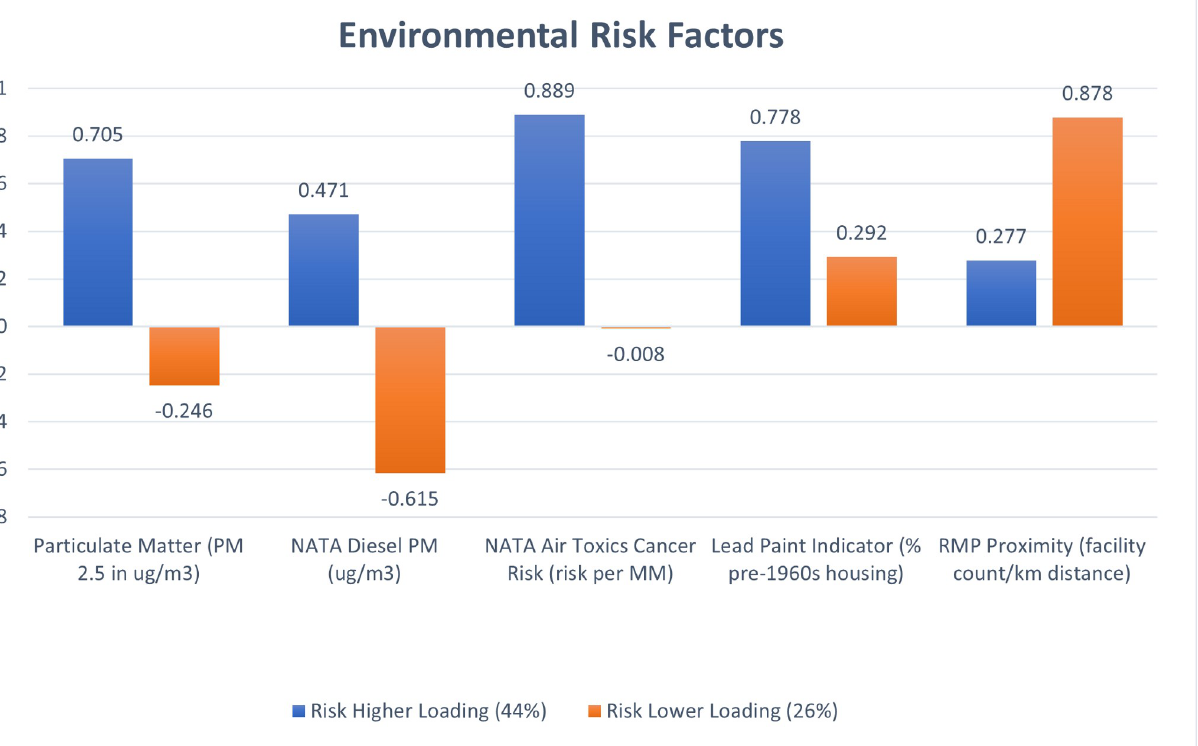
Fig 3. Population vulnerability factors identify the two components from PCA and statistically represent the parallel populations within each small town. Higher scores indicate more vulnerability. https://doi.org/10.1371/journal.pone.0252127.g003 PLOS ONE | https://doi.org/10.1371/journal.pone.0252127 June 23,